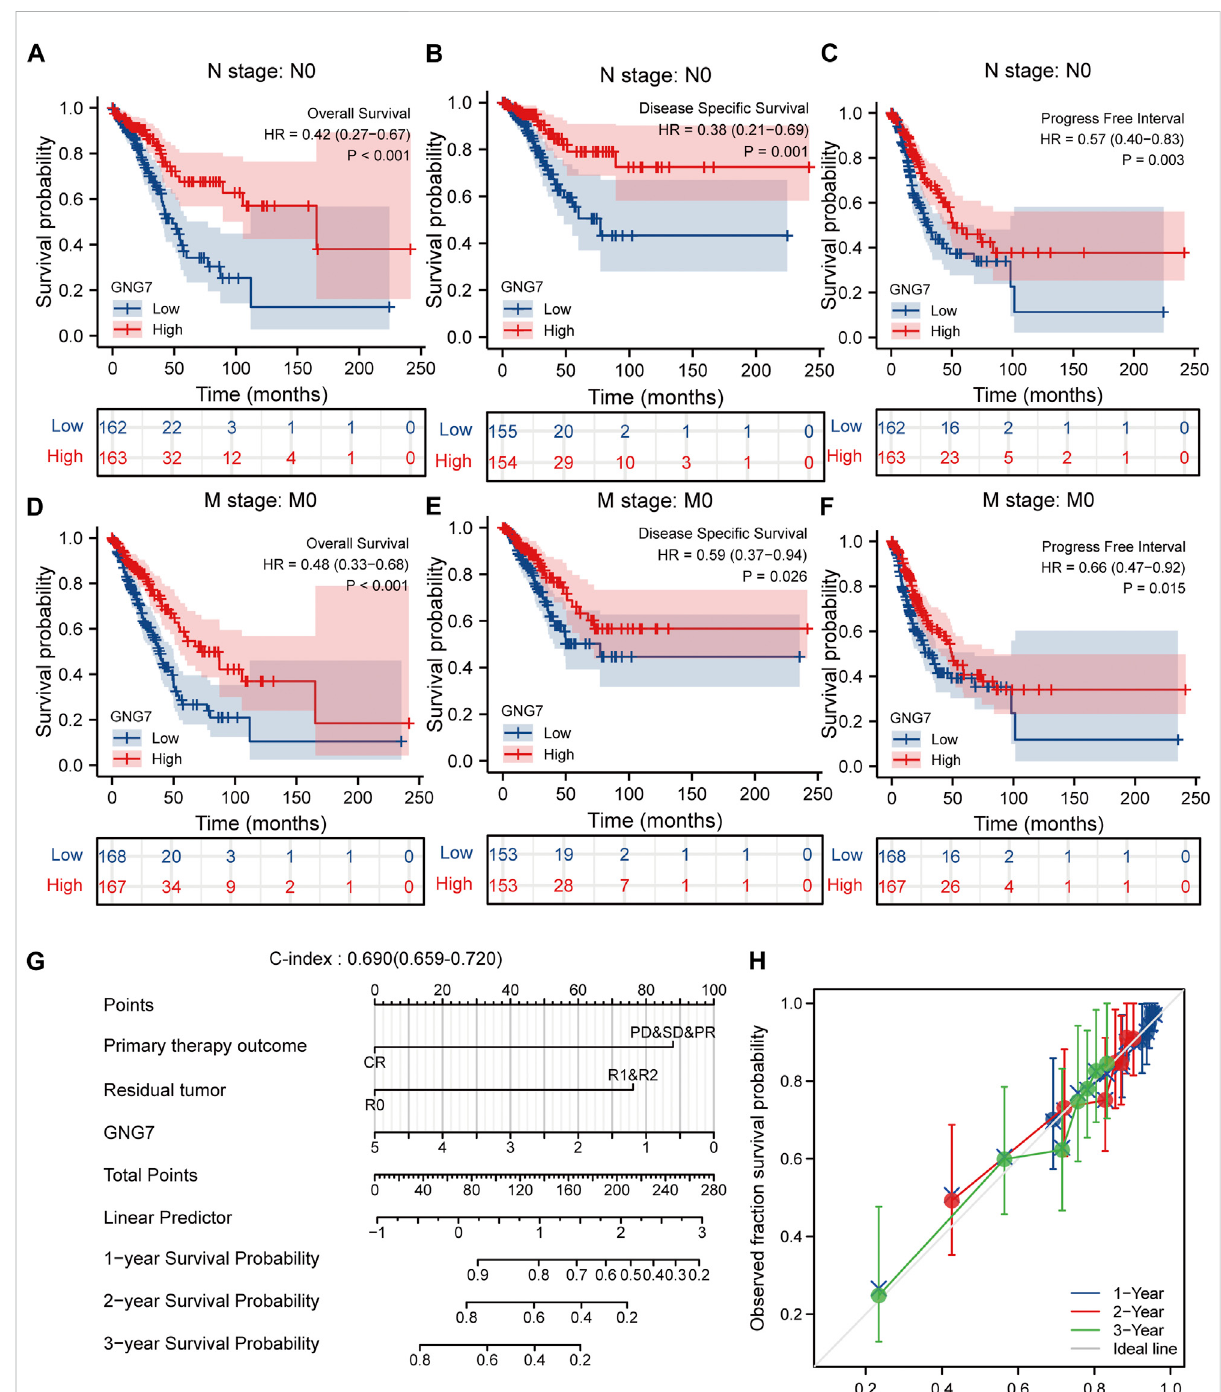
FIGURE 4 Subgroup analysis and the construction of a nomogram based on GNG7 expression. (A – C) The Kaplan-Meier curves of OS (A) , DSS (B) , and PFI (C) between GNG7-high and-low expression patients withLUADinN0stage. (D – F) The Kaplan-Meier curves ofOS (D) , DSS (E) ,and PFI (F) between GNG7-highand-lowexpressionpatientswithLUADinM0stage. (G) AnomogramthatintegratesGNG7andotherindependentprognosticfactorsin LUADfromTCGAdata. (H) Thecalibrationcurveofthenomogram.OS,overallsurvival;DSS,diseasespeci fi csurvival;PFI,progressfreeinterval; LUAD, lung